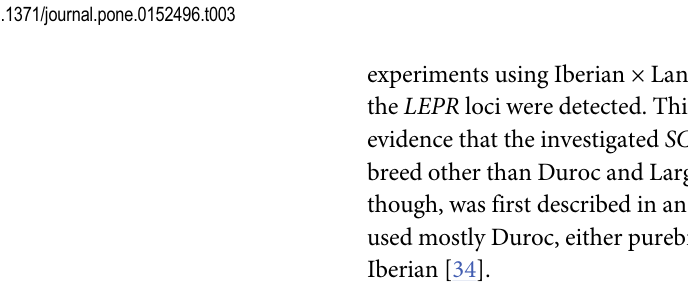
Subcutaneous fat SFA, %